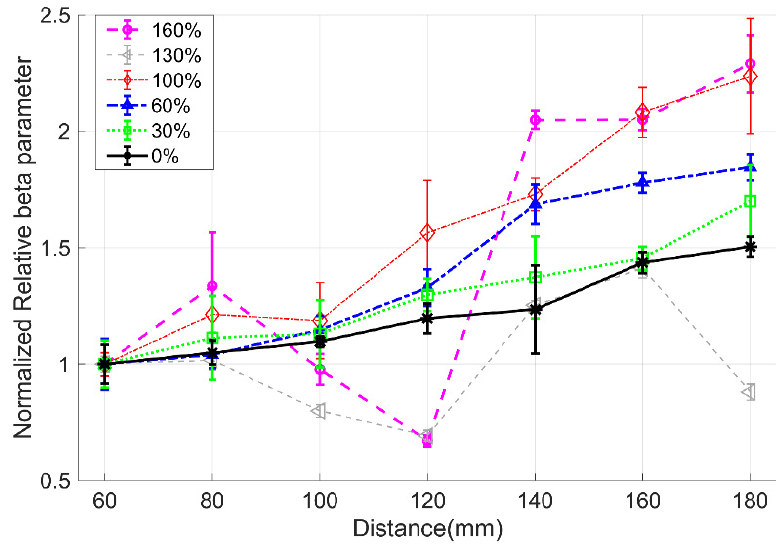
Figure 10. Nonlinearity for fatigue-damaged spring rods.